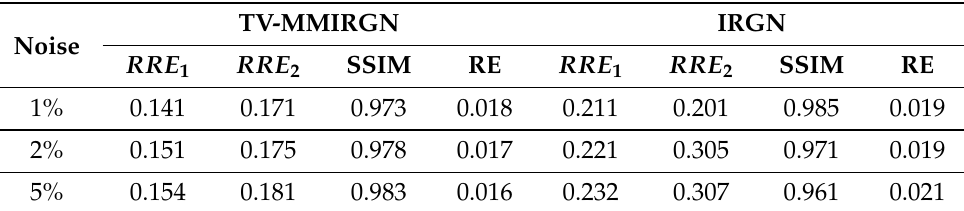
Table 2. Reconstruction errors from Example 2.